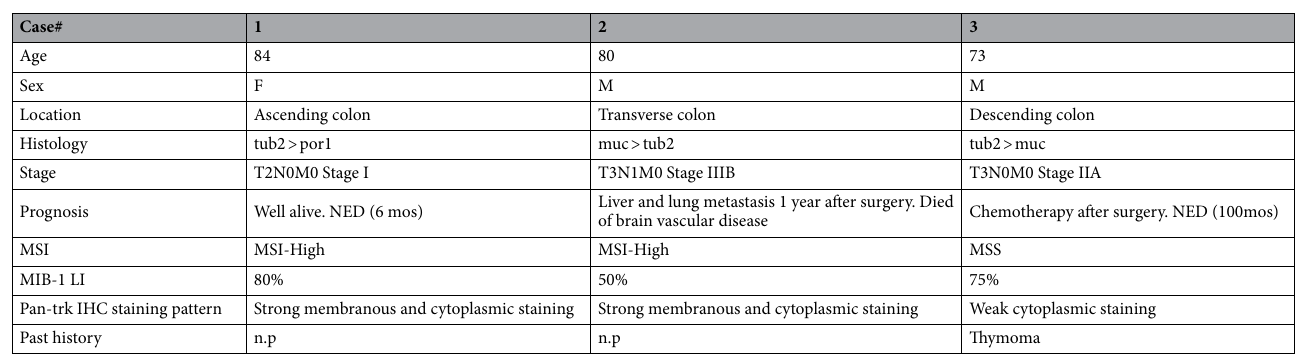
Table 2. Clinicopathological features of 3 CRC cases with NTRK